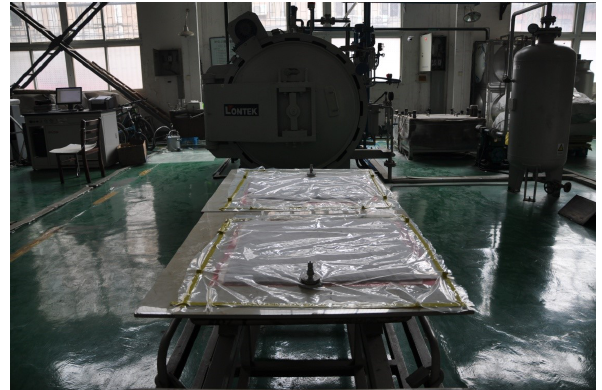
Figure 1: An illustration of sample making Table 1: Properties of unidirectional CFRP Lamina Property CFRP Longitudinal Young’s modulus, E 11 (GPa)